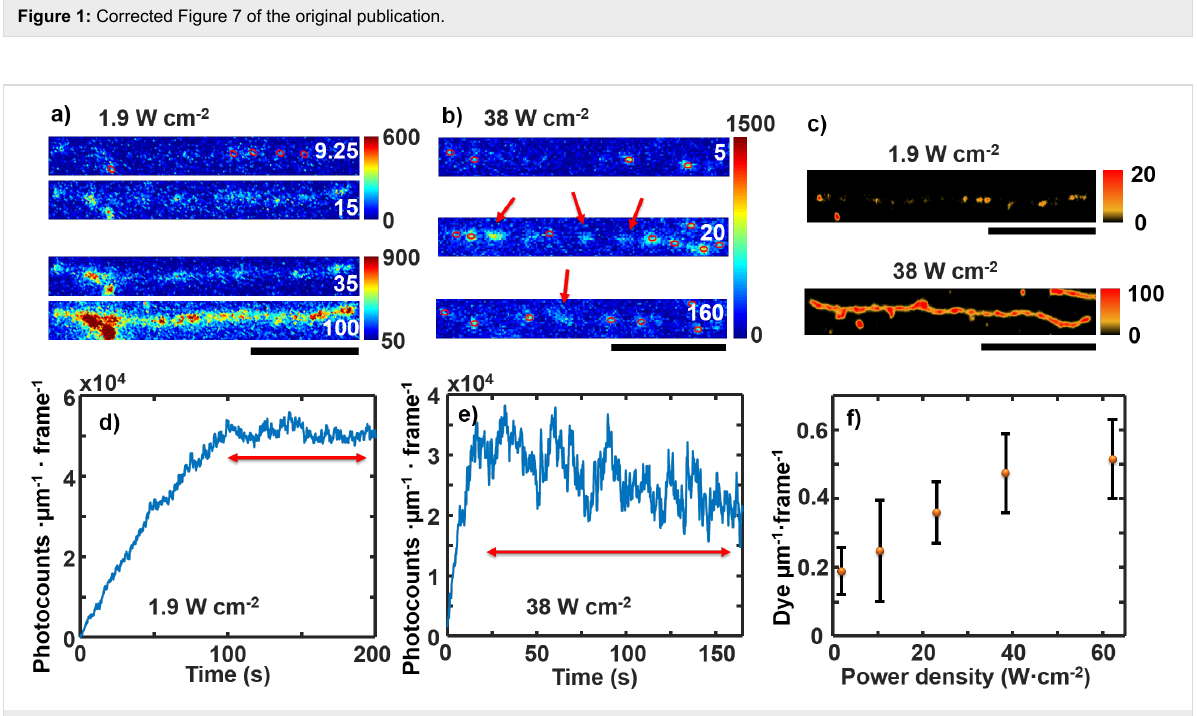
Figure 2: Corrected Figure 8 of the original